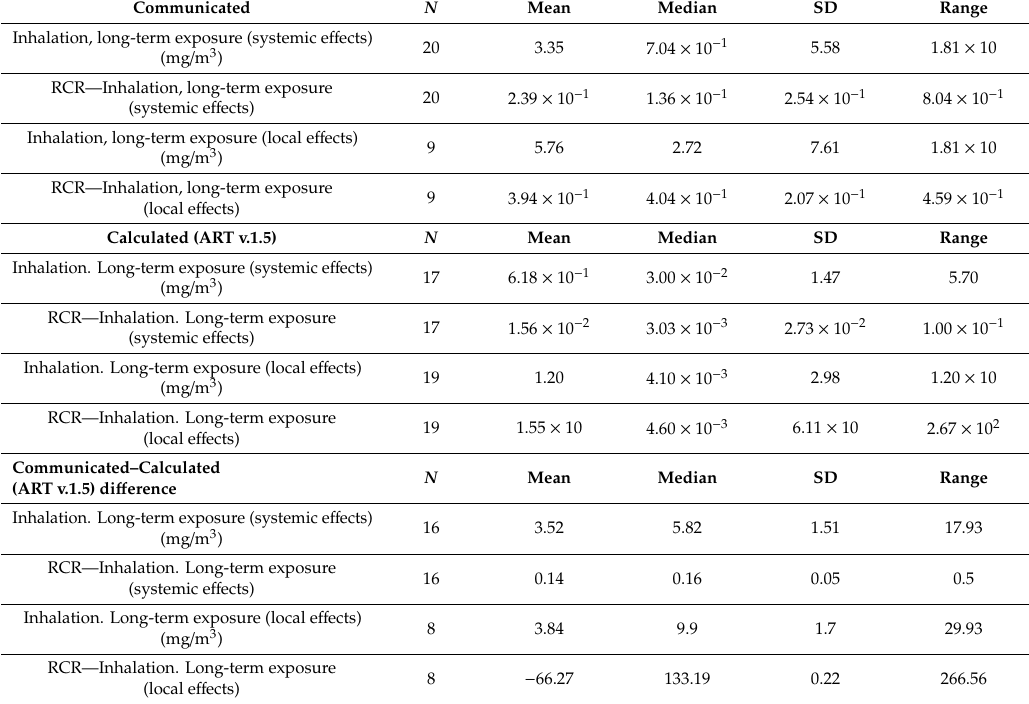
Table 11. Comparison and di ff erence between communicated exposure estimates and calculated exposure estimates with ART v.1.5 with associated RCRs. N: number of valid exposure estimates. SD: standard